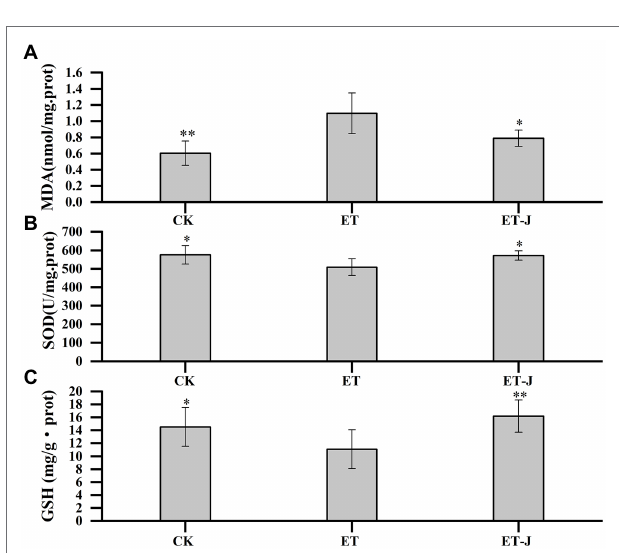
FIGURE 3 | Effect of fermentation broth on oxidative stress parameters of liver in alcoholic liver disease (ALD) mouse model, including (A) malondialdehyde (MDA), (B) superoxide dismutase (SOD), and (C) glutathione (GSH). CK, mice were administrated with 0.9% normal saline; ET, mice were administrated with liquor; and ET-J, mice were administrated with liquor and fermentation broth (0.1 ml/10 g). Results are expressed as the mean ± SD ( n = 14). * p < 0.05 vs. ET; ** p < 0.01 vs. ET.